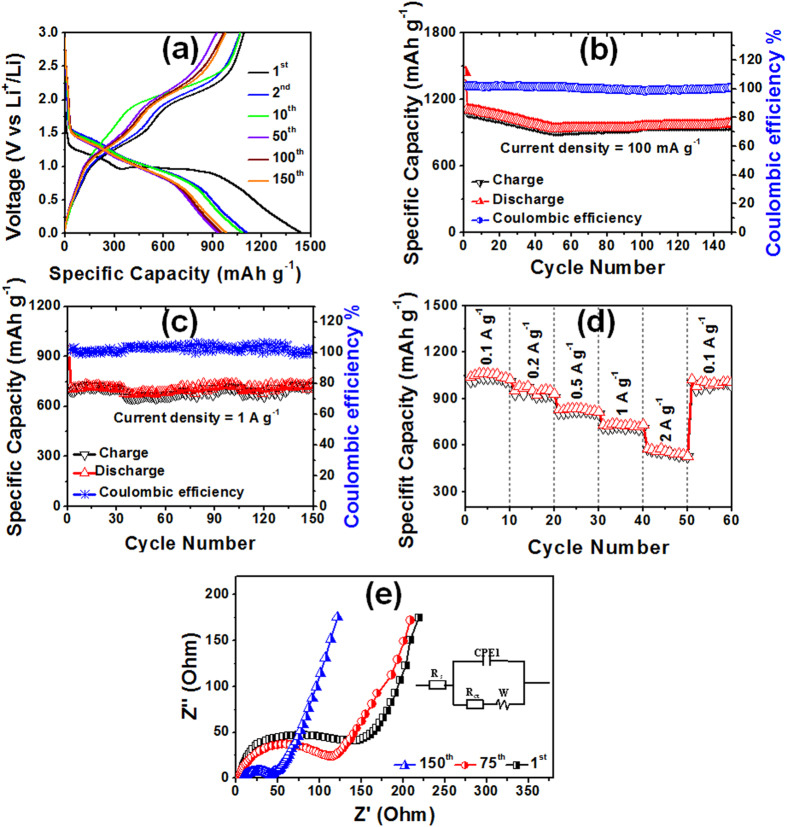
Electrochemical properties of the W2@Co3O4 composite anode for LIB.(a) Galvanostatic charge/discharge profiles for the 1st, 2nd, 10th, 50th, 100th and 150th cycle at 100 mA g−1. (b) Plots of charge-discharge capacities versus cycle number and the Coulomb efficiency at a current density of 100 mA g−1 between 0.01 and 3.0 V. (c) Capacity vs. cycle number and the corresponding Columbic efficiency at a current density of 1 A g−1. (d) Rate performance at various current densities from 0.1 to 2 A g−1 in the voltage range of 0.01–3.0 V. And e, the Nyquist plots for the W2@Co3O4 nanofibers after 1, 75 and 150 cycles with the inset of the simulation model of the equivalent circuit.